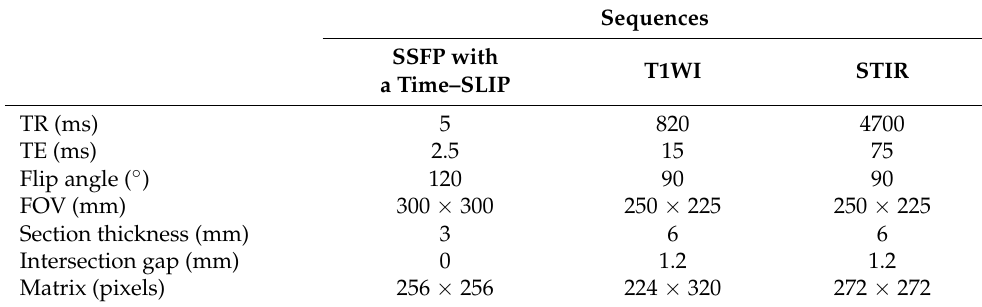
Table 1. Imaging